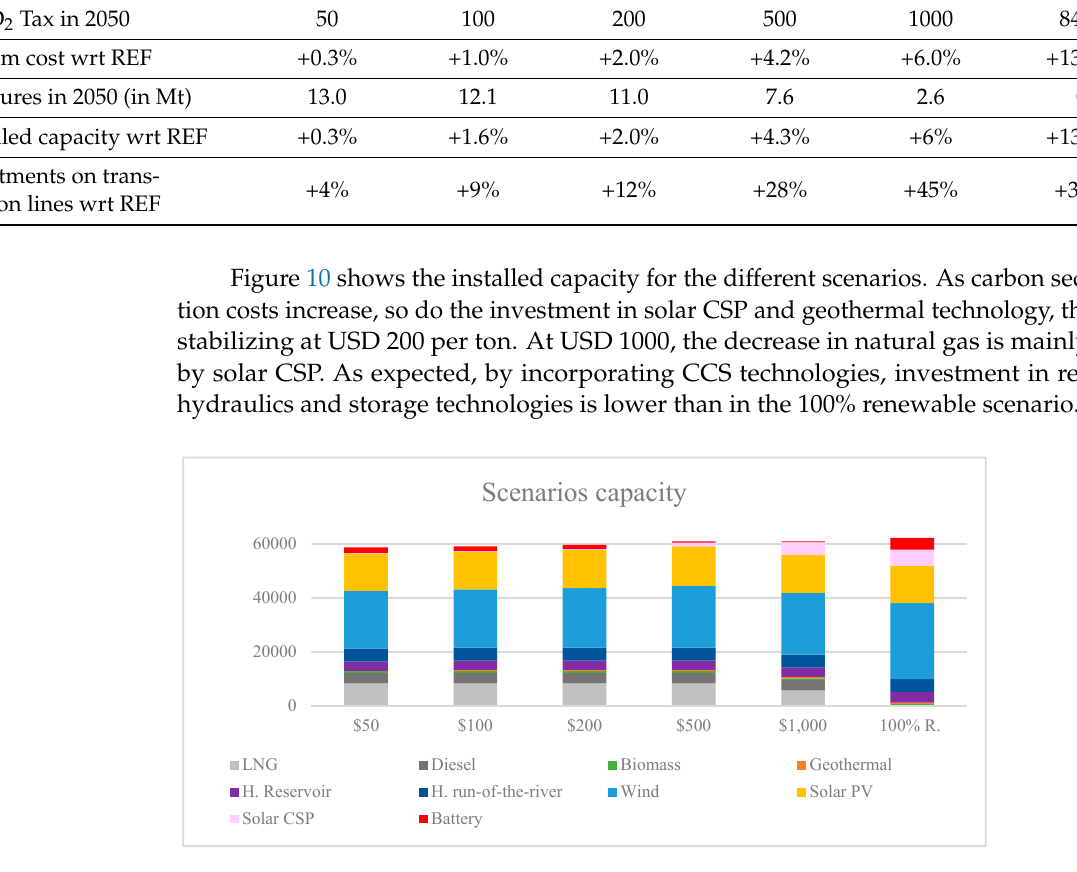
Figure 10. Capacity in MW of each technology, in 2050, for each cost of neutralizing emissions and 100% R. scenario.